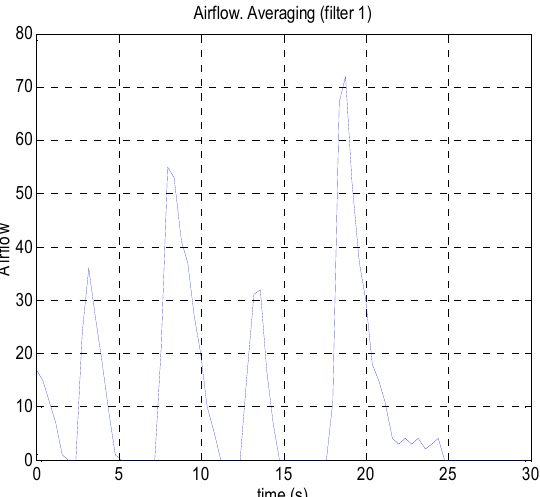
Figure 13. Airflow sensor tested; the user takes alternately a deep and a moderate breath. Filter type 1 was applied.